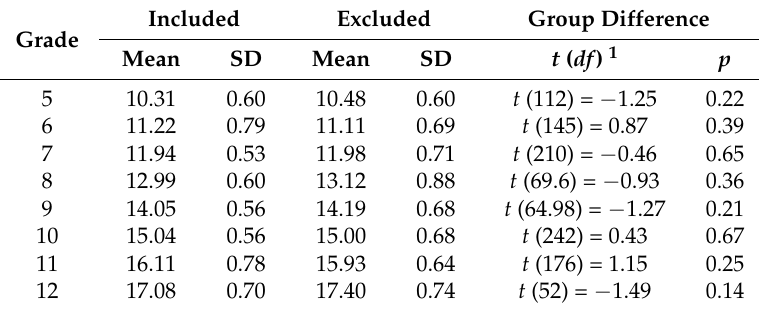
Table A1. Difference in age between included and excluded respondents by grades.